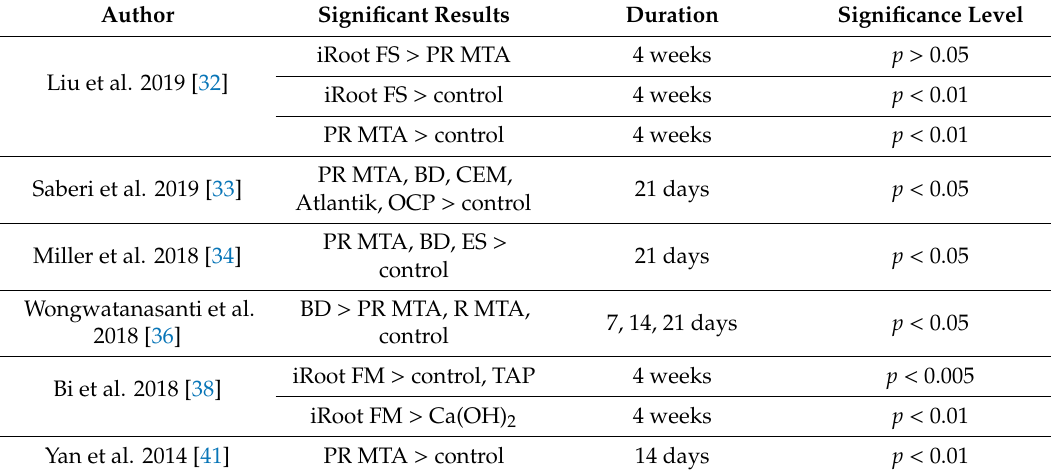
Table 6. Summary of the results of included studies showing significant di ff erences between bioceramic materials or a bioceramic material and a control for hSCAP mineralization potential